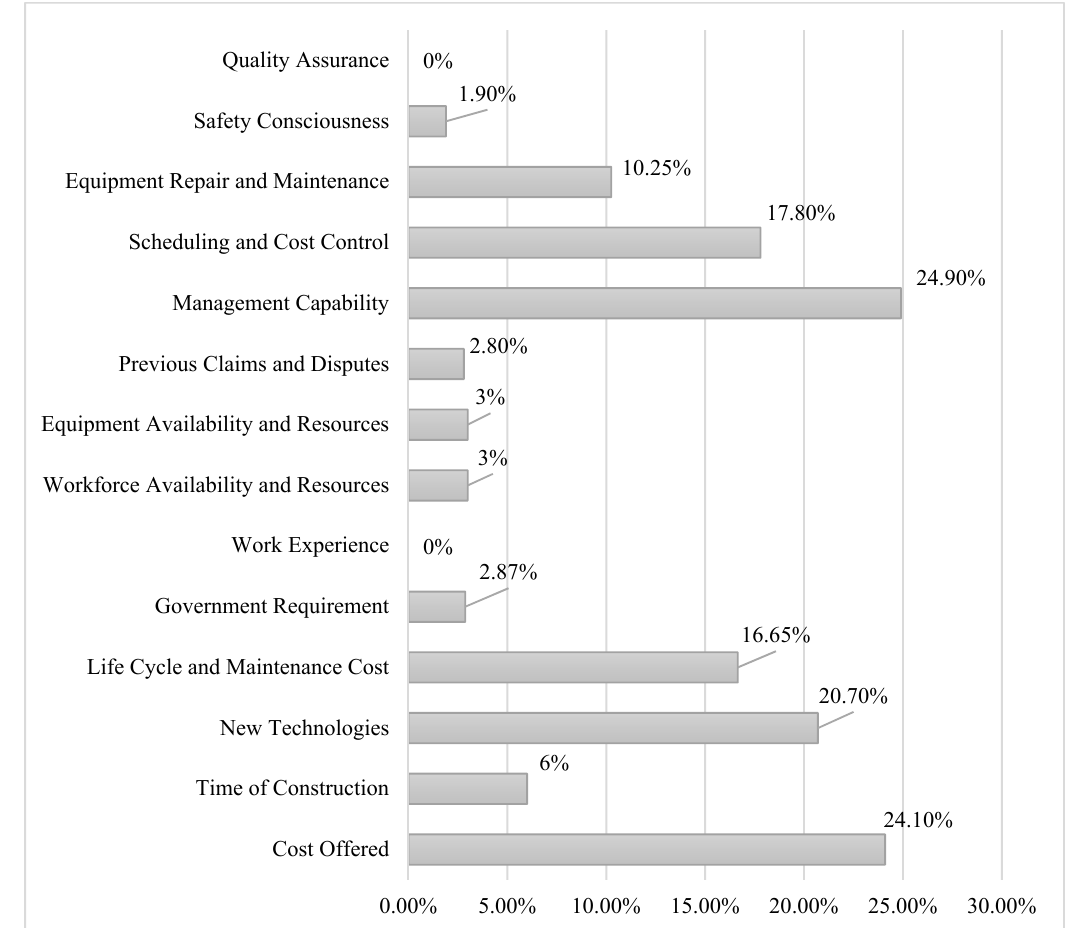
Figure 9. Impact of BIM on TSC.